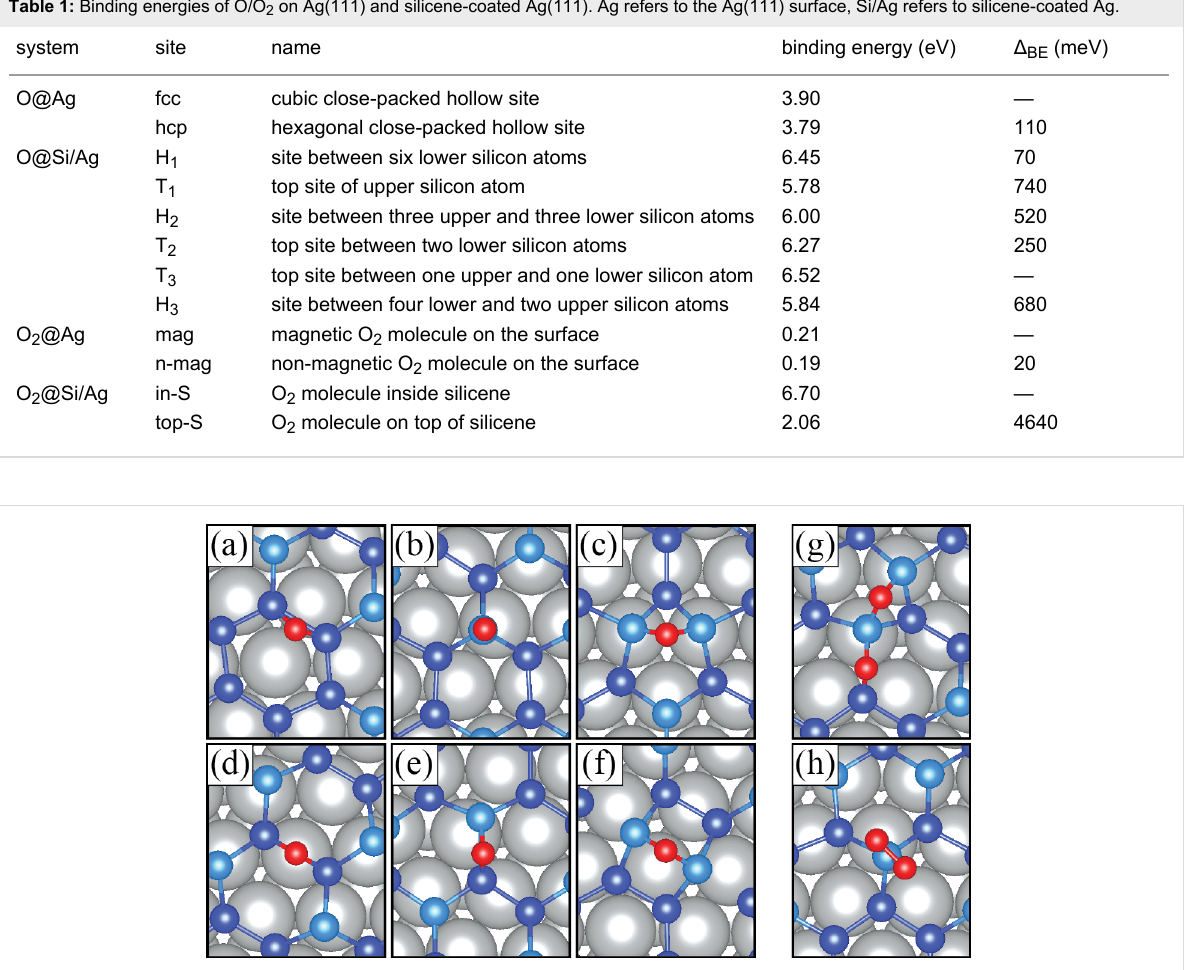
Figure 4: Final configurations of silicene-coated Ag(111) after capturing an oxygen atom at the sites (a) H 1 , (b) T 1 , (c) H 2 , (d) T 2 , (e) T 3 and (f) H 3 . Final configurations (g) in-S and (h) top-S of silicene-coated Ag(111) after capturing an O 2